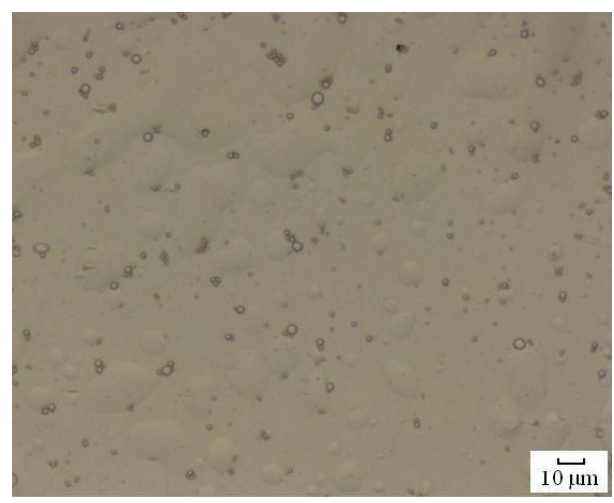
Figure 4. The electronic microscope.